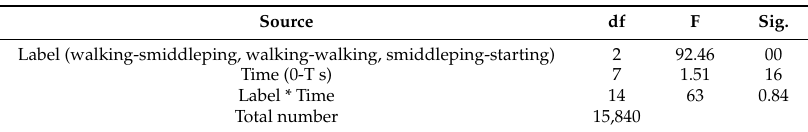
Figure 7. Vehicle speed diagram under different crossing intentions. ( a ) Vehicle speed at different times with different intentions. ( b ) Mean vehicle speed under different intentions. Table 3. Main effect test table.